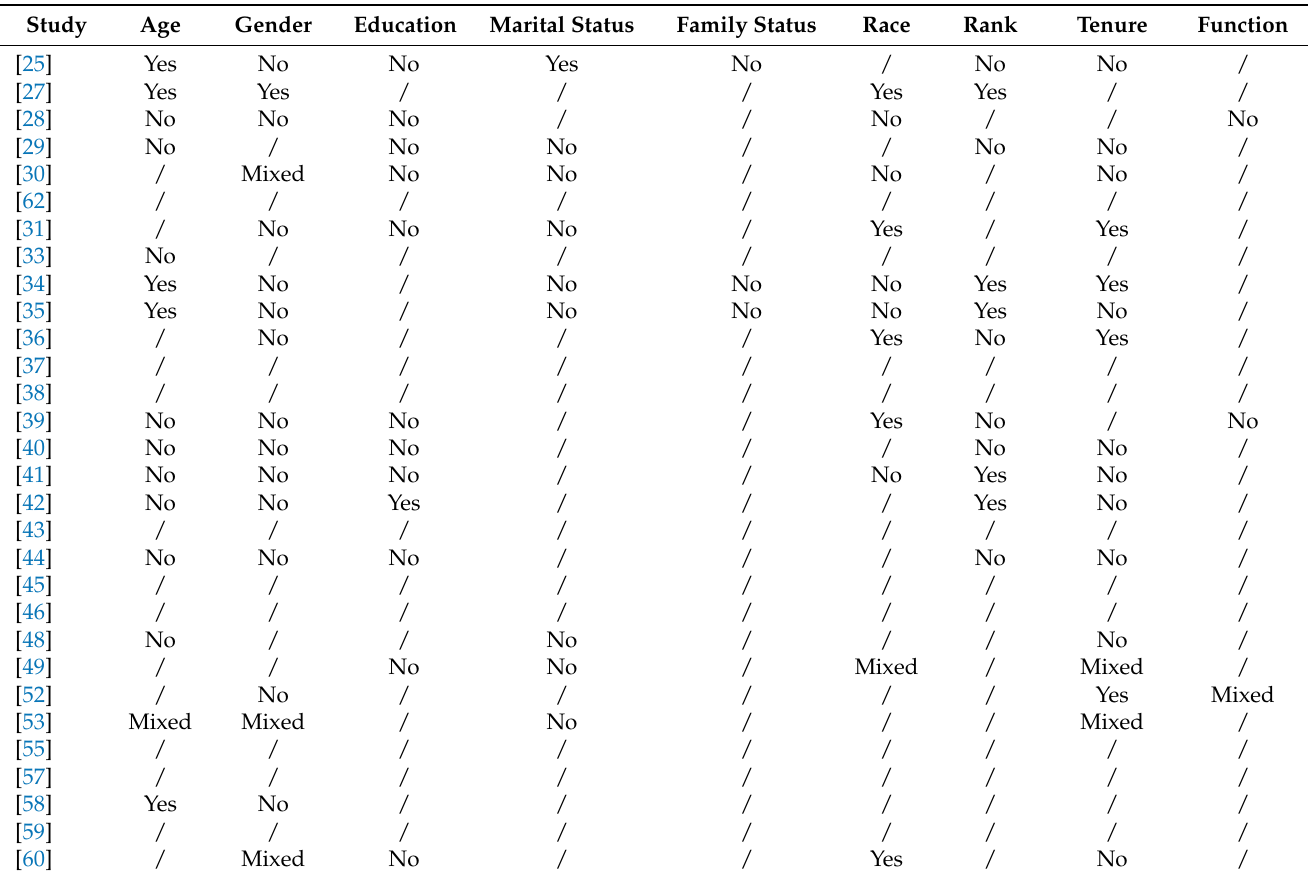
Table 3. Demographic predictors of police work-related